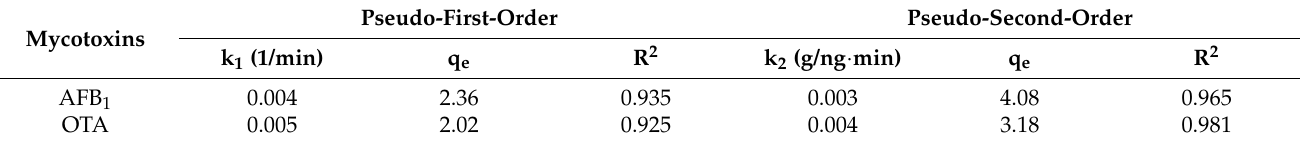
Table 3. Adsorption kinetics parameters of mycotoxins sorption onto adsorbent (T = 40 ◦ C and pH =